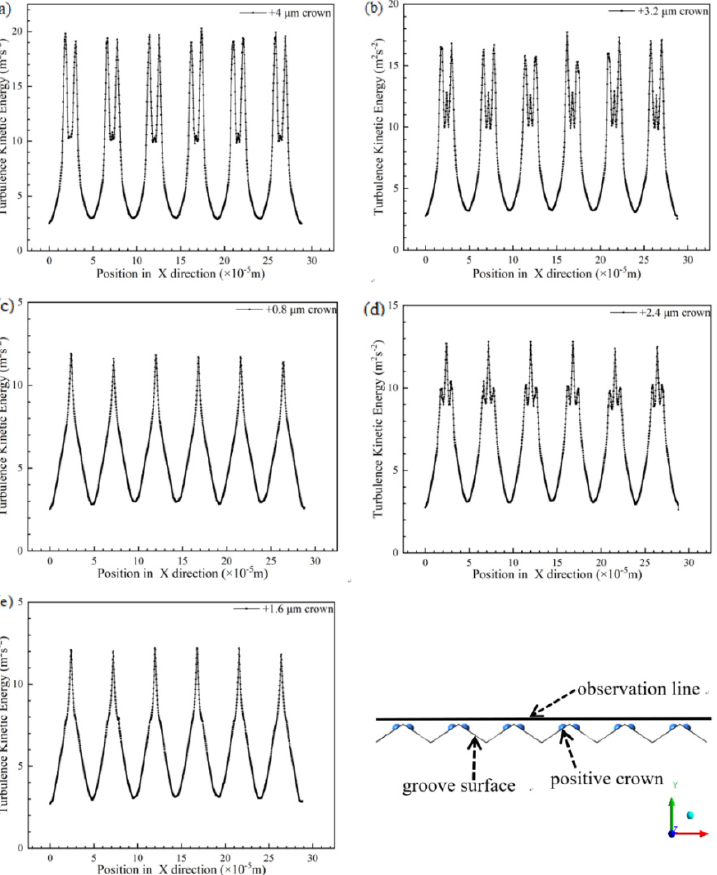
Figure 9. The turbulent kinetic energy which perpendicular to flow direction. From ( a – e ), the height of the positive spherical crown changes from +4 μ m to +0.8 μ m.